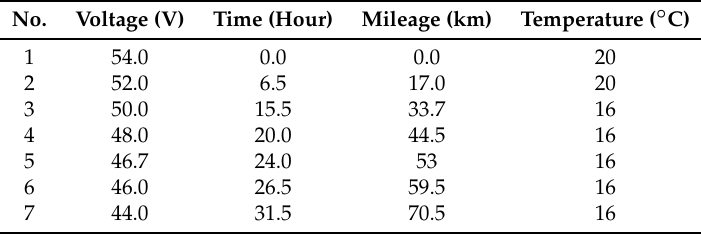
Table 2. Testing results of operation endurance at each timestamp.